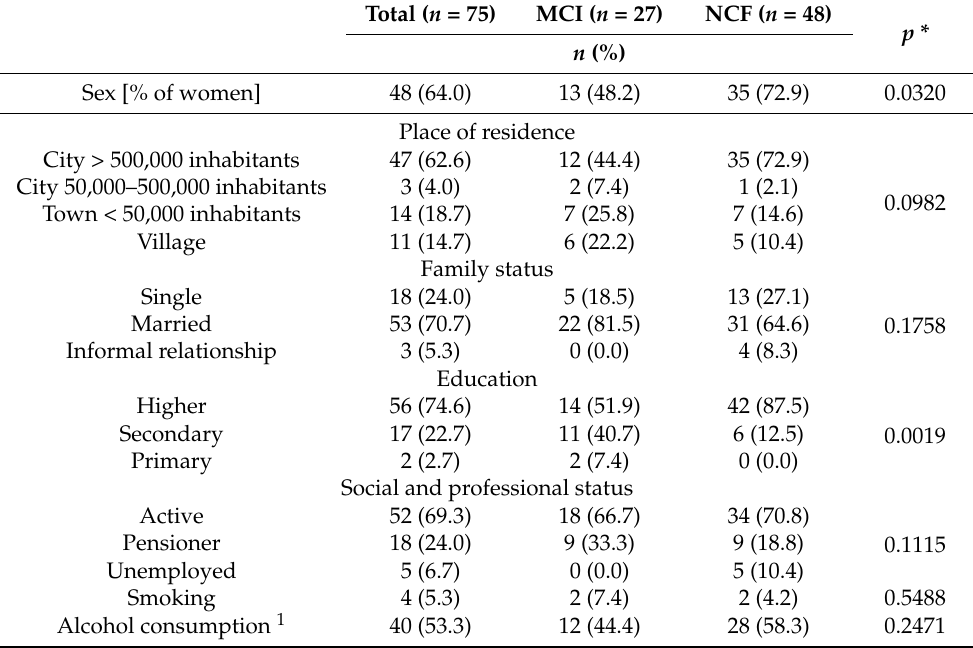
Table 2. Socio-economic characteristics of the study population.